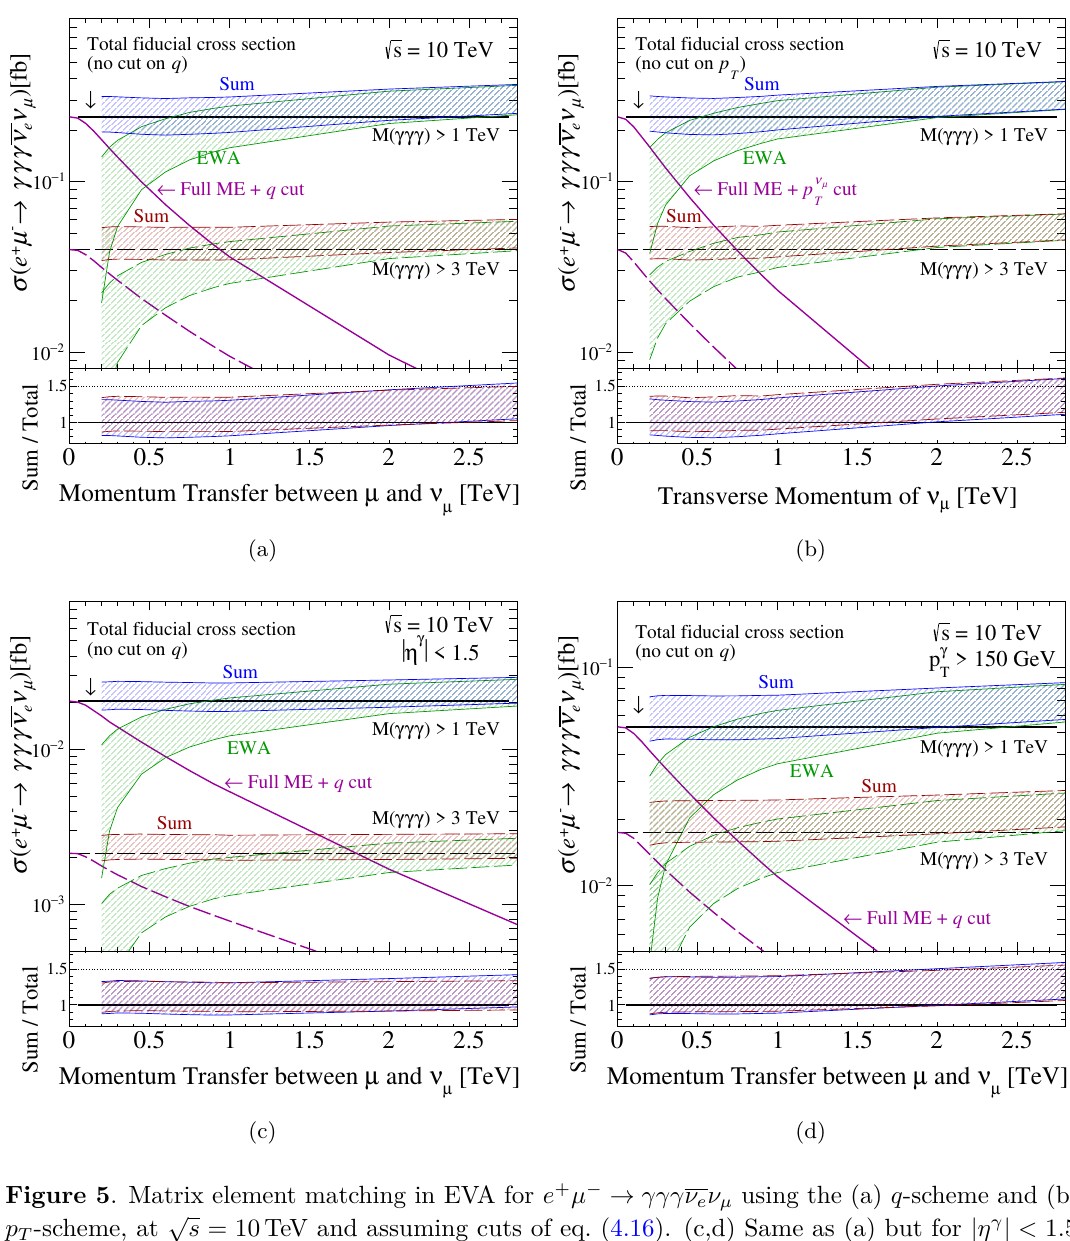
Figure 5 . Matrix element matching in EVA for e + µ − → γγγν e ν µ using the (a) q -scheme and (b) √ p T -scheme, at s = 10 TeV and assuming cuts of eq. (4.16). (c,d) Same as (a) but for | η γ | < 1 . 5 and p γ > 160 GeV , T